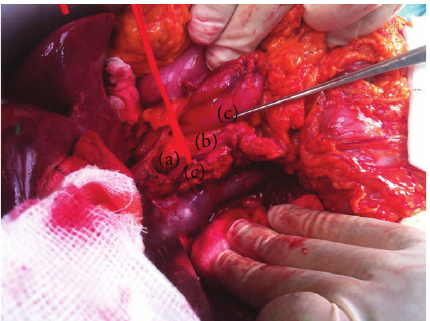
Figure 2: Pancreatoduodenectomy with preservation of GDA. (a) GDA, (b) anterior pancreaticoduodenal arcade, and (c) stumps of superior posterior and inferior posterior pancreaticoduodenal